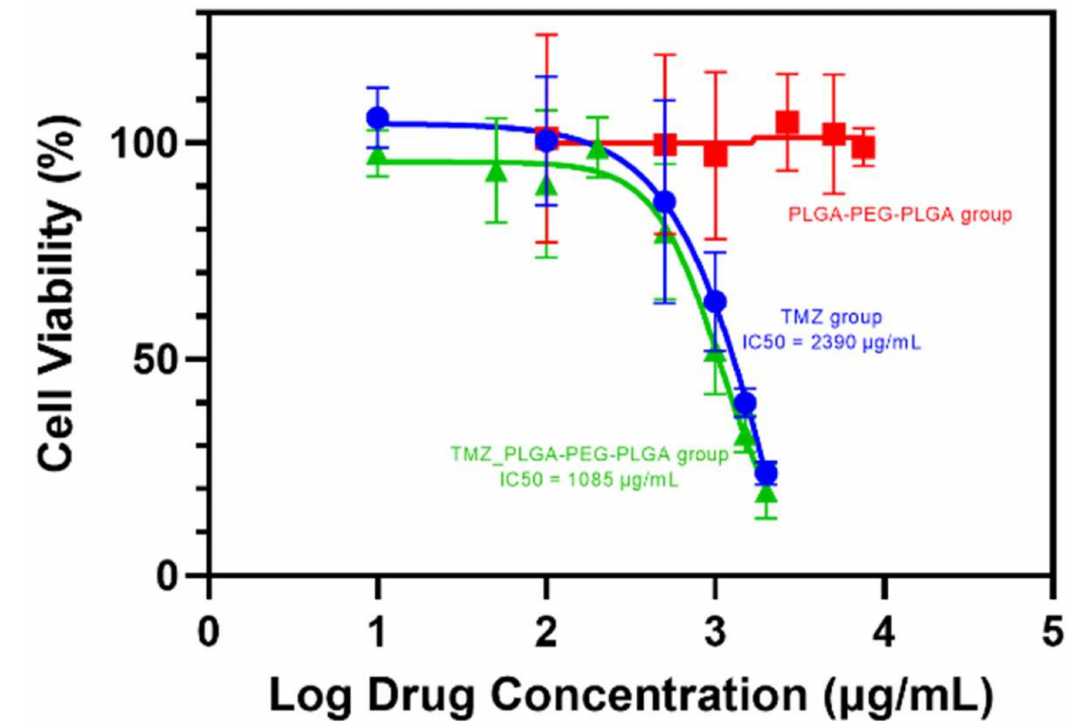
Figure 9. TMZ, TMZ and PLGA–PEG–PLGA, PLGA–PEG–PLGA group anti-proliferation level on U87–MG/Luc cell in vitro as determined by the MTT